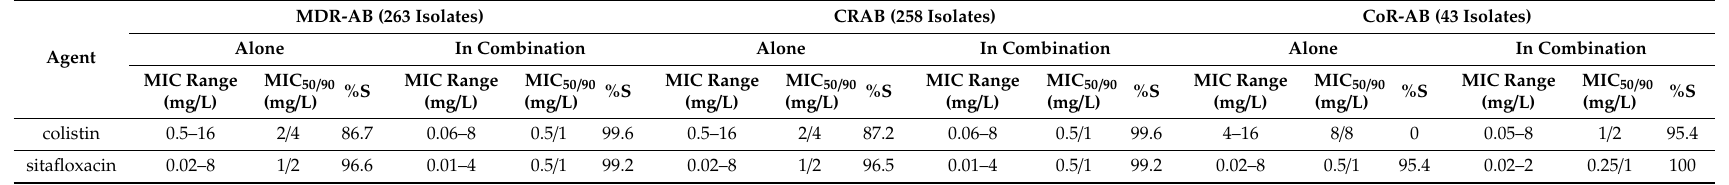
Table 1. Activity of colistin and sitafloxacin against A. baumannii as single agents and in